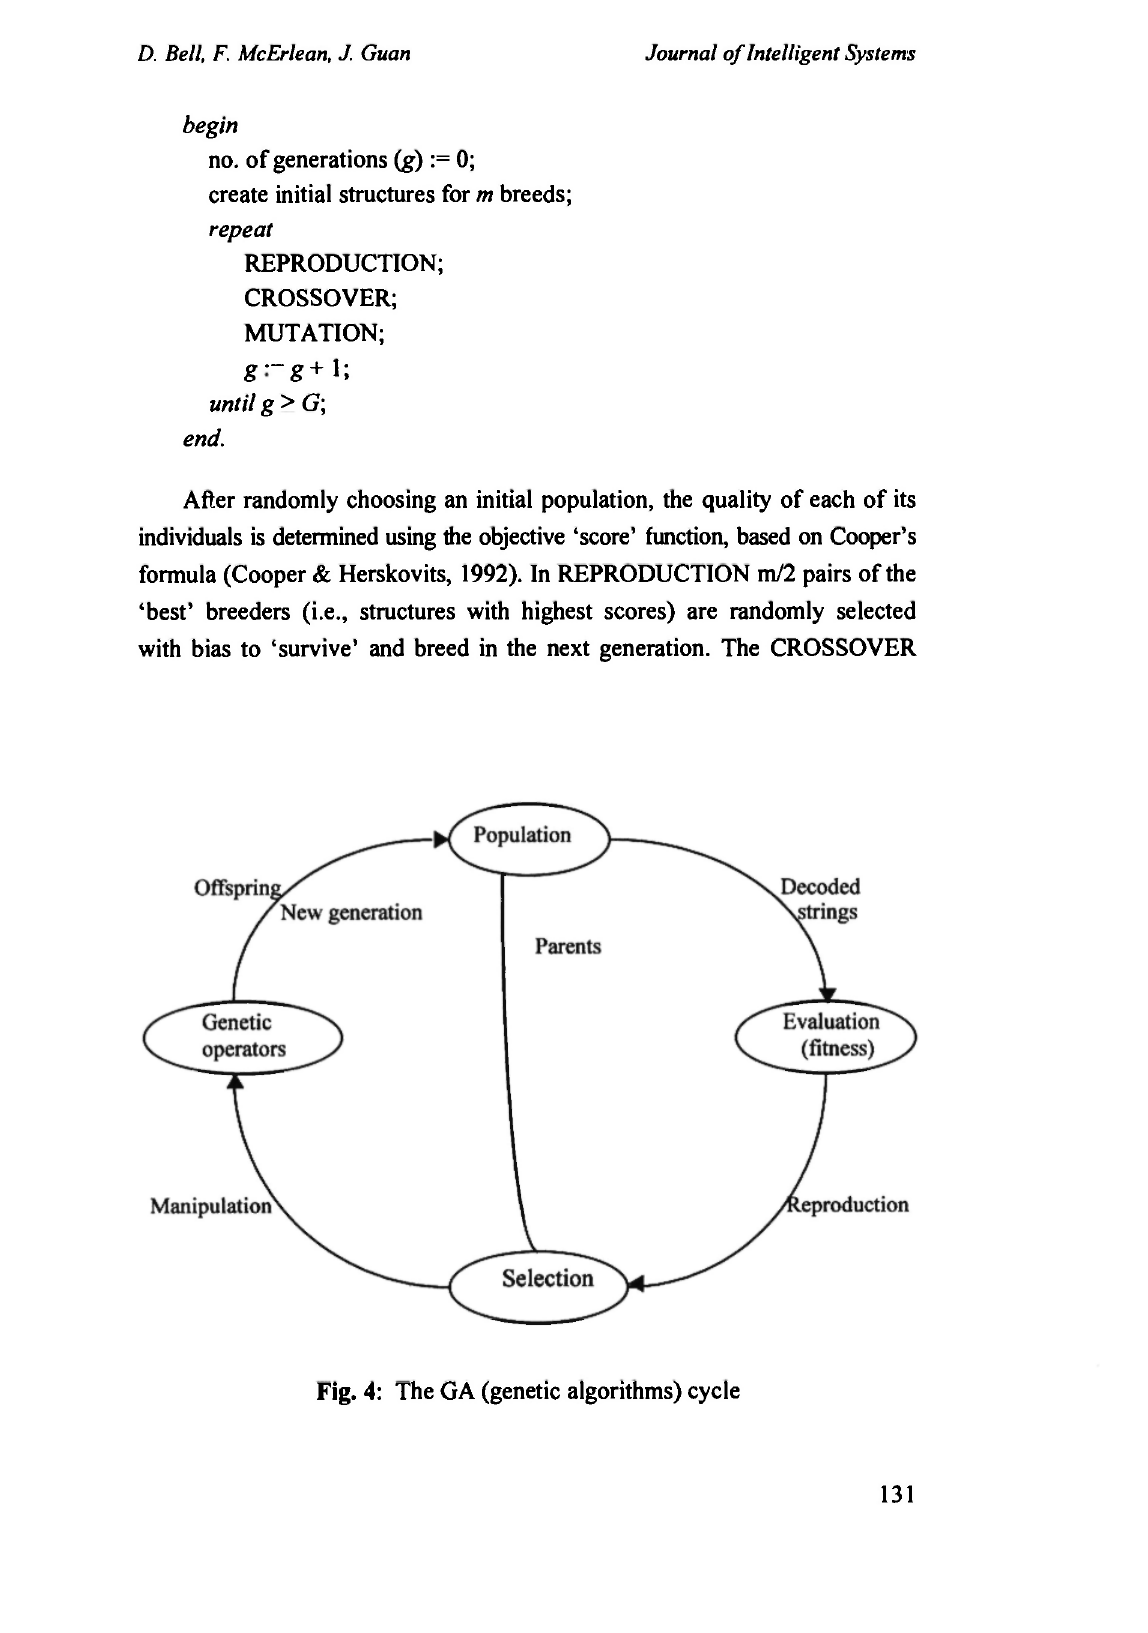
Fig. 4: The GA (genetic algorithms)